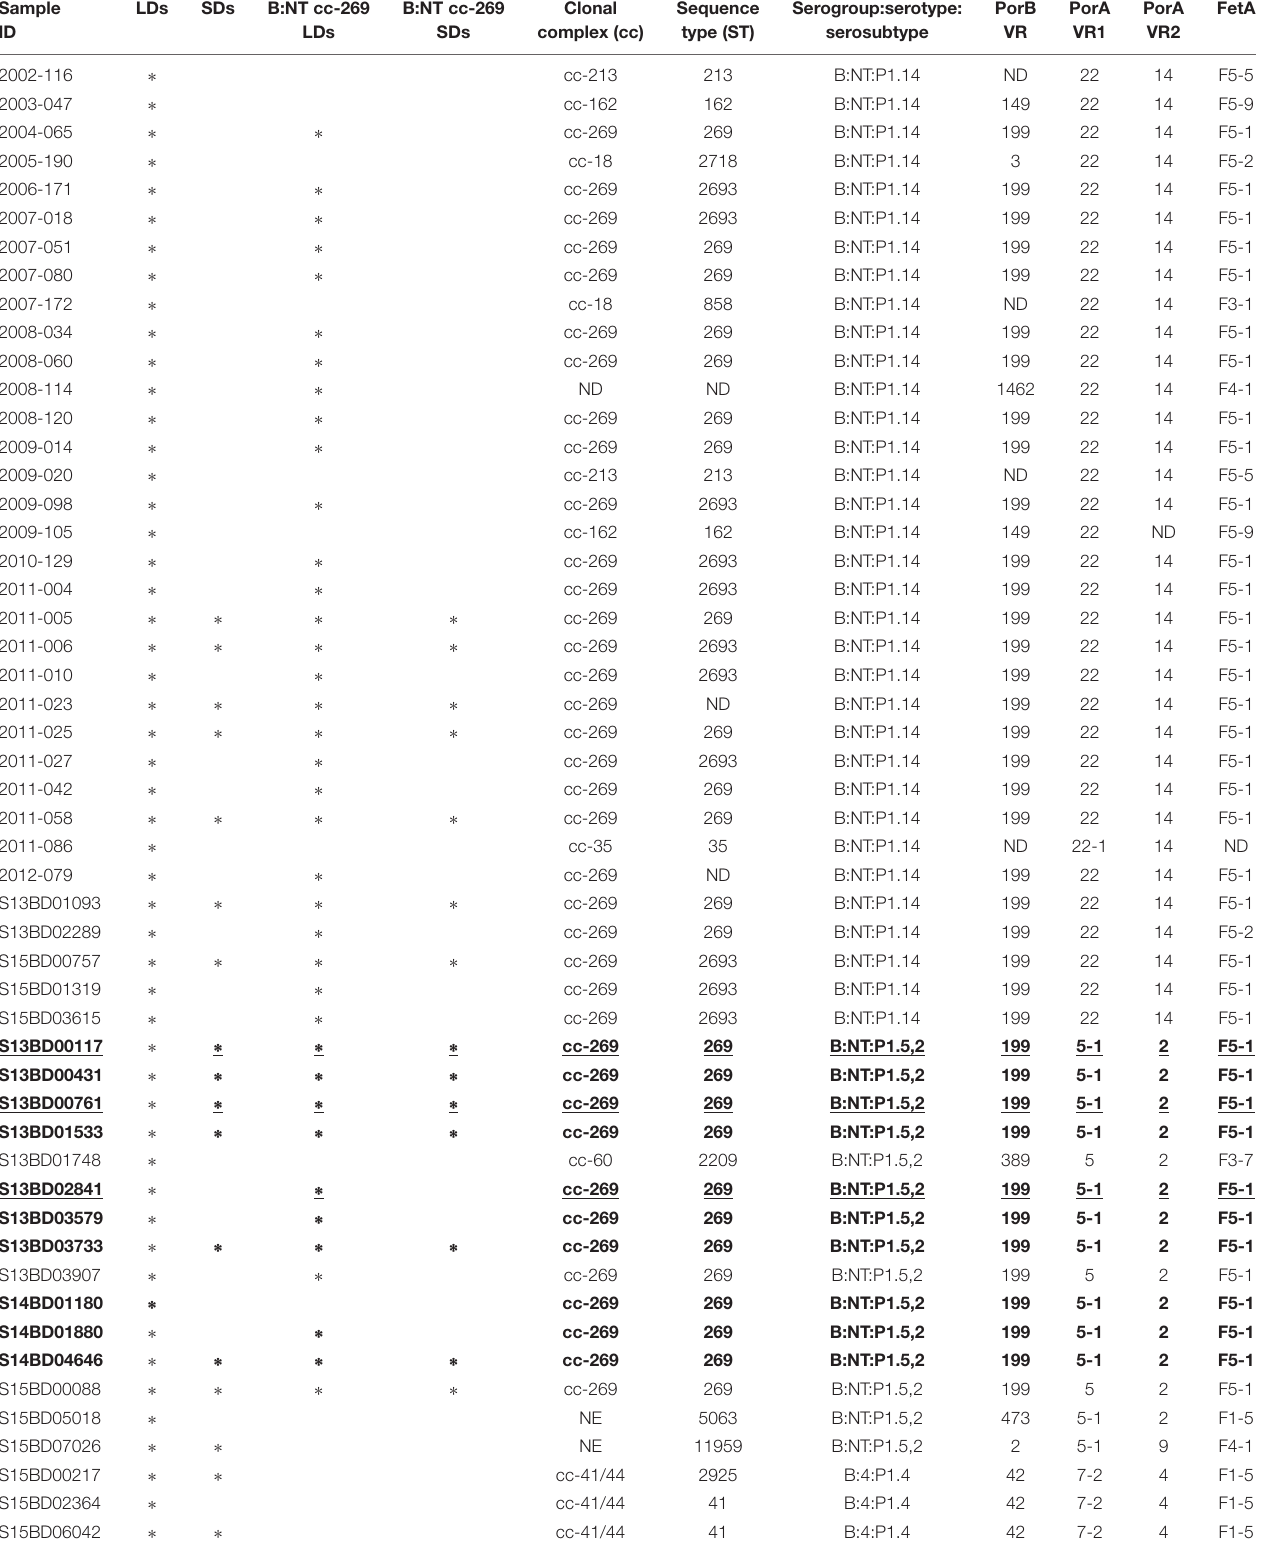
TABLE 1 | Isolates used in this study.